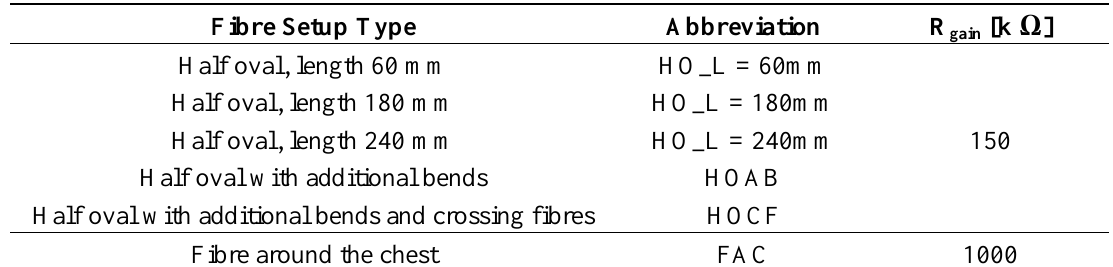
Table 1. Description of fibre types with their